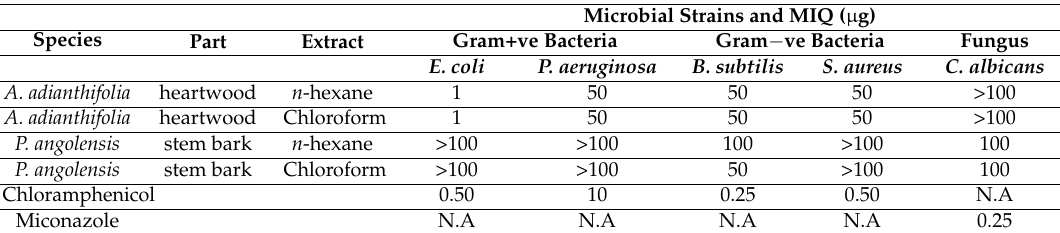
Table 4. Preliminary antimicrobial activity of the different extracts.